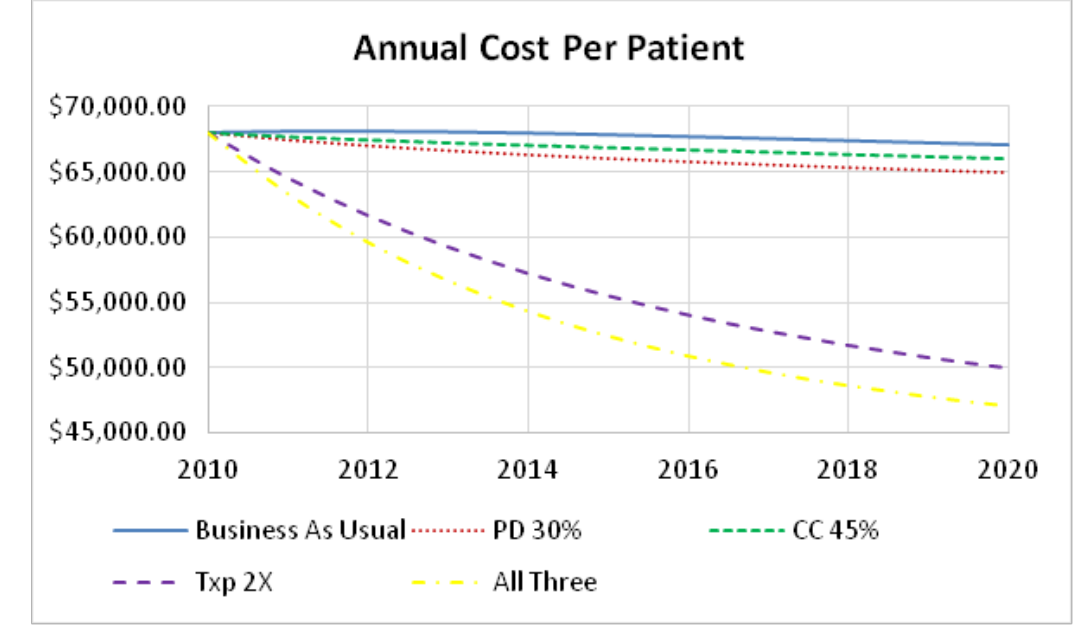
Figure 4. Annual Cost per Patient by